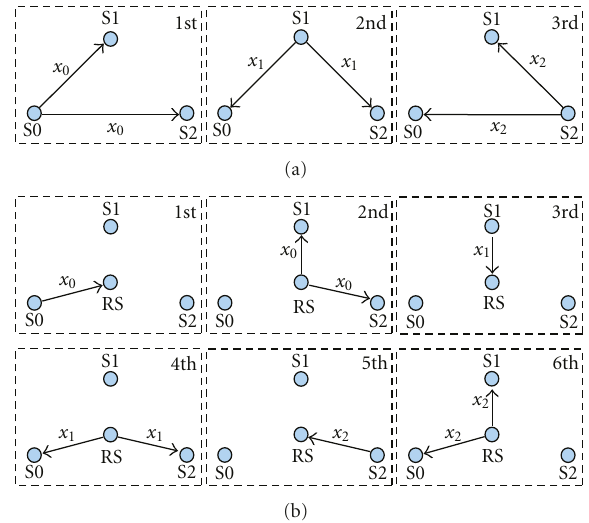
Figure 1: Multi-way communication: (a) with direct link; (b) with the assistance of a relay station using the one-way relaying protocol.